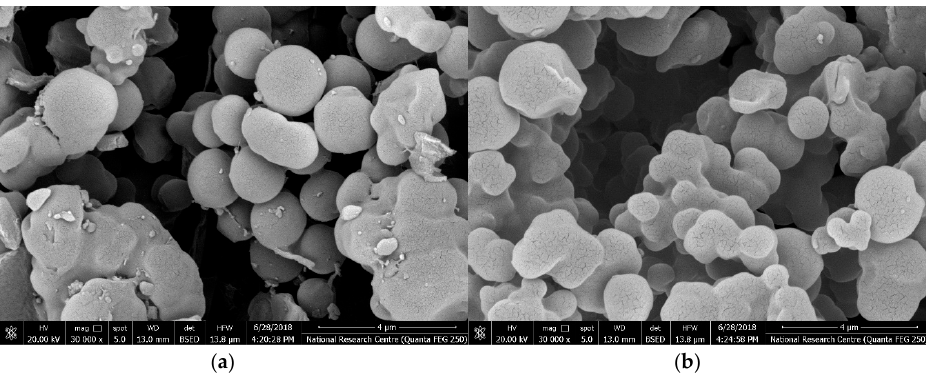
Figure 1. SEM images of ( a ) molecularly imprinted polymers (MIP) and ( b ) non-imprinted polymer (NIP)